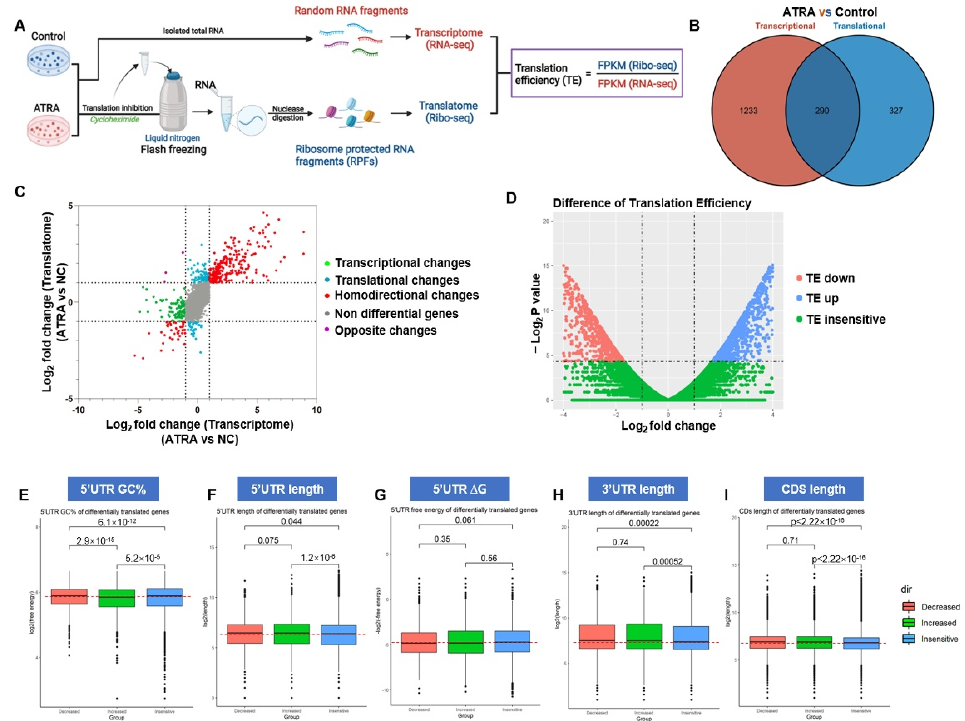
Figure 4. Translation atlas in AML cells in response to ATRA stress was established using RNA ‐ seq combined with Ribo ‐ seq. ( A ) Schematic representation of the sequencing flow chart and definition of TE for each gene. ( B ) Identification of genes significantly regulated by ATRA using RNA ‐ seq (transcriptome) and Rbio ‐ seq (translatome). The number of genes transcriptionally or translationally regulated by ATRA is shown. ( C ) Nine quadrant diagram showing the distribution of genes in transcriptome and translatome. ( D ) Volcano plot of genes with different TE; TE, translational efficiency. ( E ‐ G ) GC content ( E ), length ( F ), and free energy ( G ) of 5’UTR of differentially translated genes during ATRA stress. ( H and I ) Length of 3’UTR ( H ) or CDs ( I ) of differentially translated genes during ATRA stress.